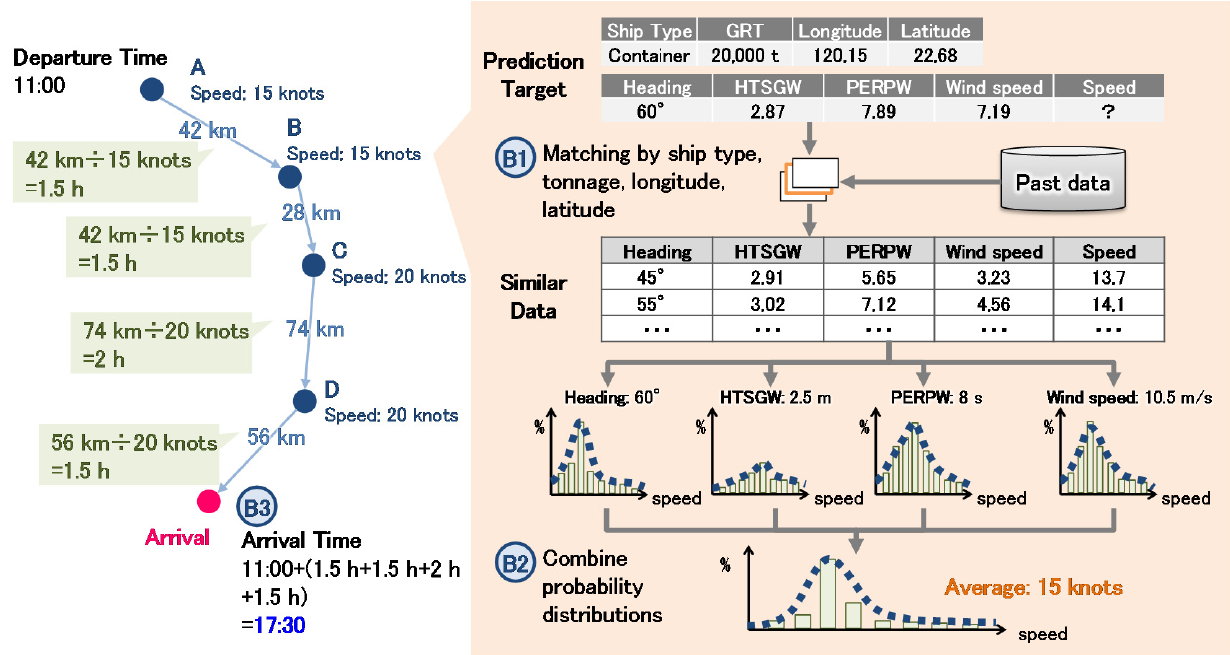
Figure 7. Overview of the procedure used to calculate the voyage speed. In B1, past data are found for similar vessels at each transit site, i.e., the longitude and latitude of the transit site of interest and past data for vessels with similar GRTs and types. Here, there are only a few data with the exact longitudes and latitudes of the transit sites of interest, so data within ± 0.1 ◦ of the exact latitudes and longitudes are used. As an example, the data shown in Figure 6 are longitudes ranging from 120.05 to 120.25 and latitudes ranging from 22.58 to